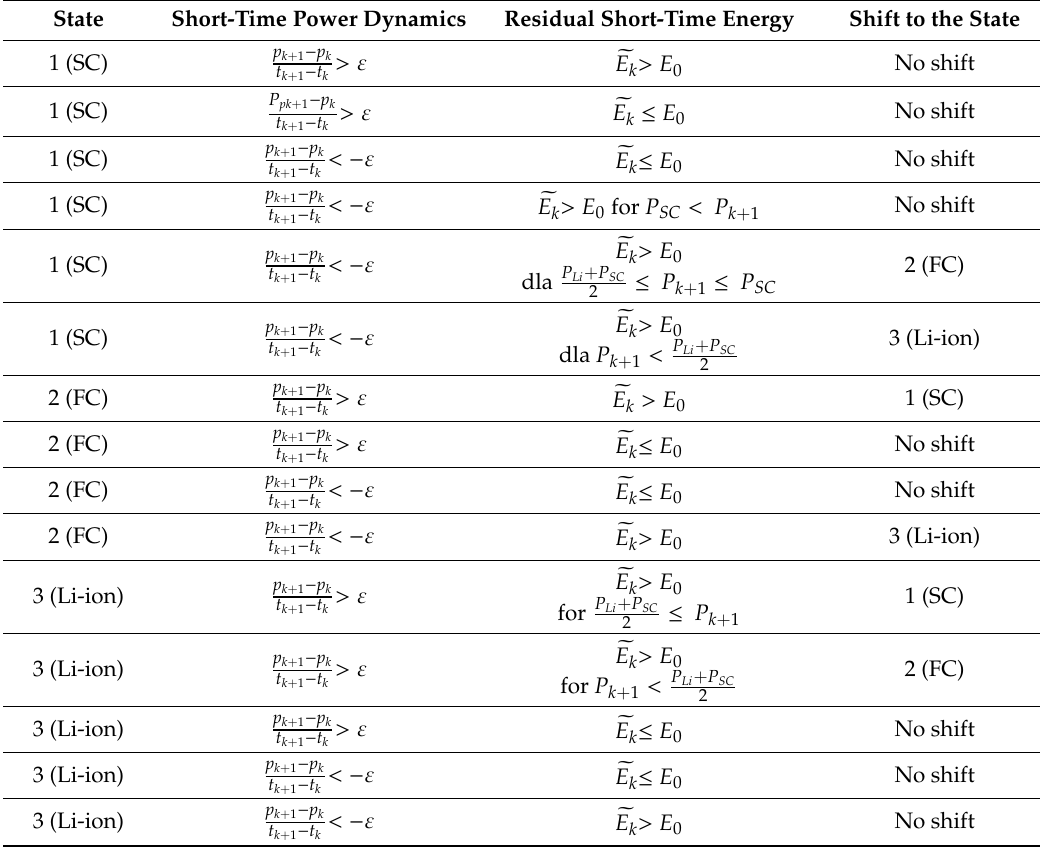
Table 2. A scheme of the shifting algorithm between elements of the hybrid energy storage system at time t = t k + 2